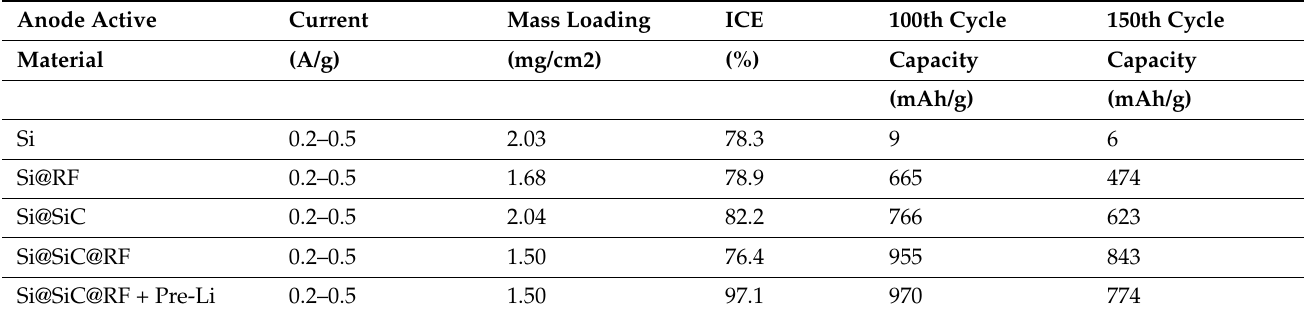
Table 1. Performance summary of